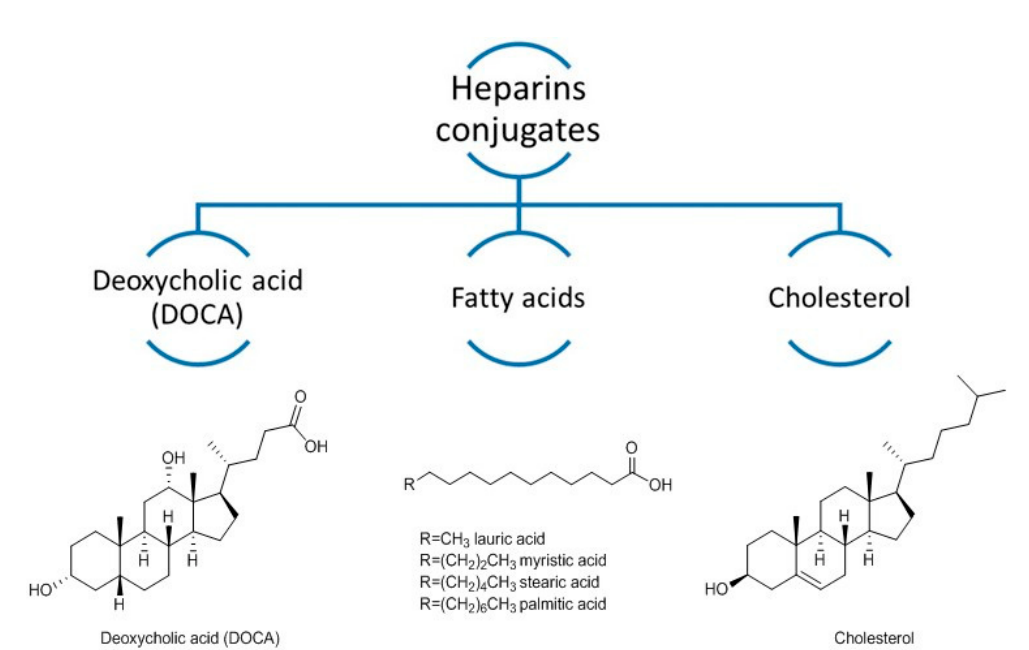
Figure 3. Chemical structure of deoxycholic acid (DOCA), fatty acids, and cholesterol.